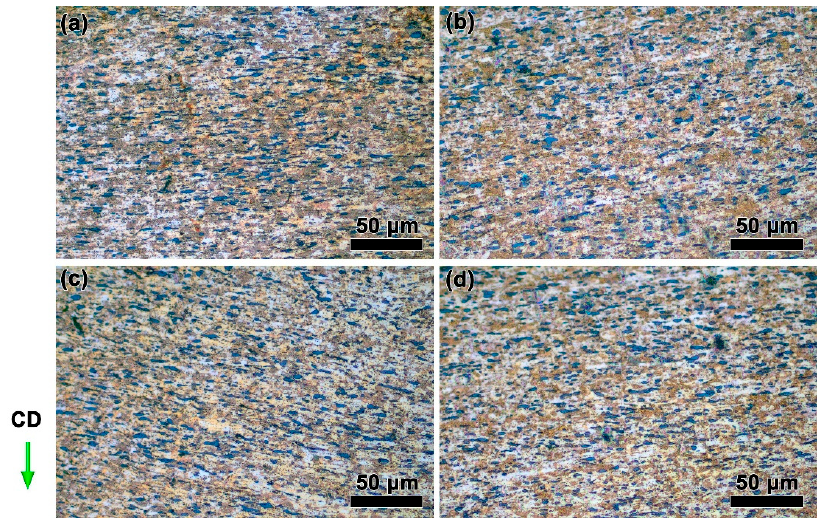
Figure 5. Microstructures of the ZnSnO 3 /Cu composites at 1 s − 1 strain rates under different temper- atures: ( a ) 650 ◦ C, ( b ) 700 ◦ C, ( c ) 750 ◦ C, and ( d ) 800 ◦ C. CD presents the compression direction of the